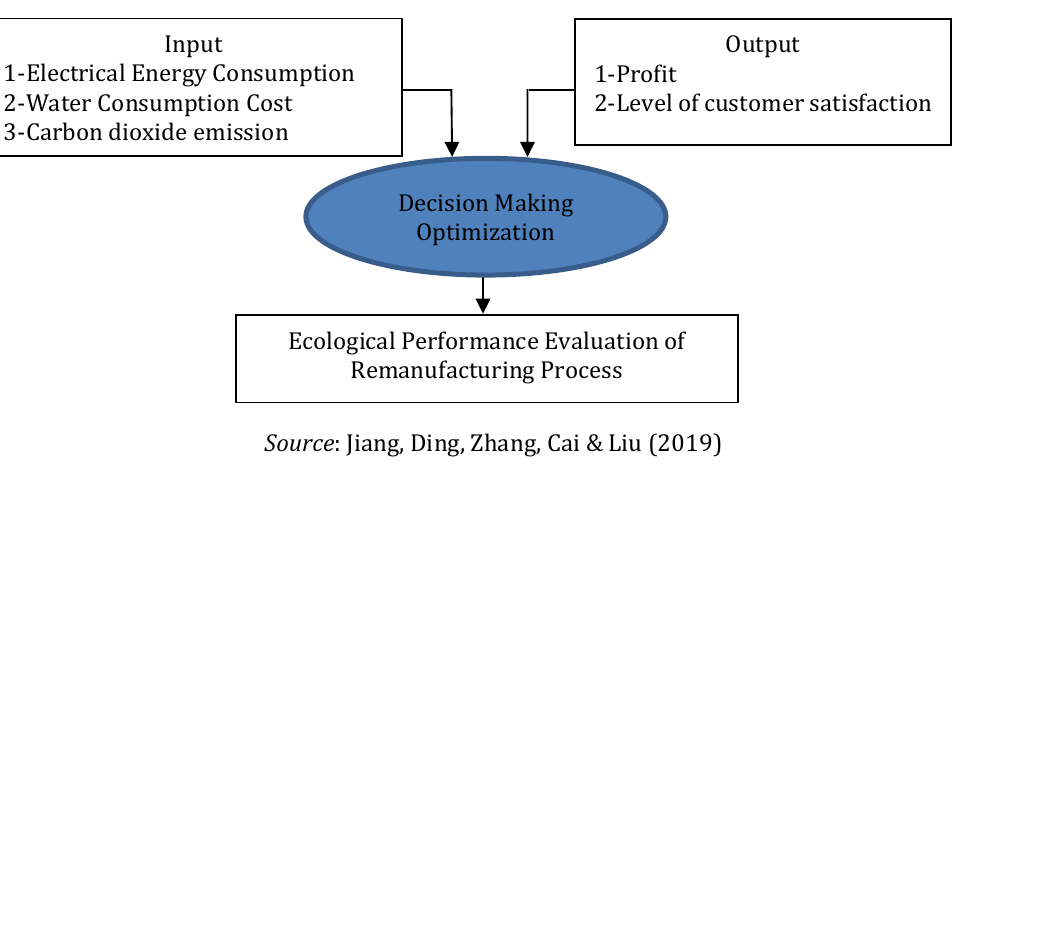
Figure 16: Evaluation methodology of Ecological performance of remanufacturing